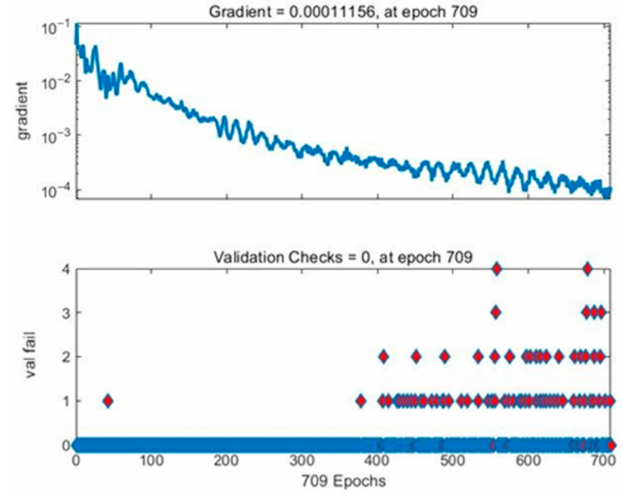
Figure 18. Gradient curve and verification check.